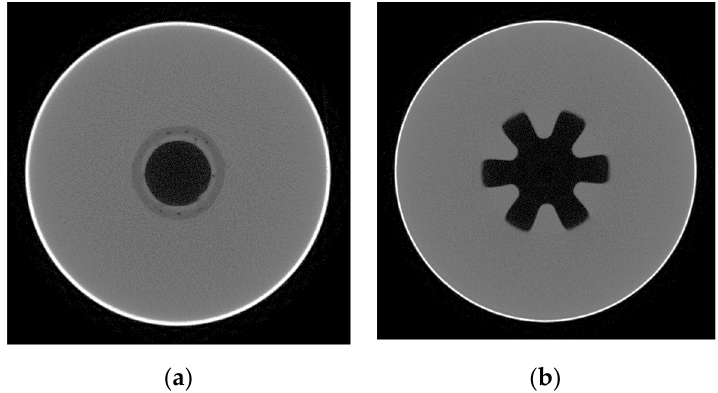
Figure 1. Partial CT images of NAWC No. 6 grain: ( a ) tube grain; ( b ) star grain.